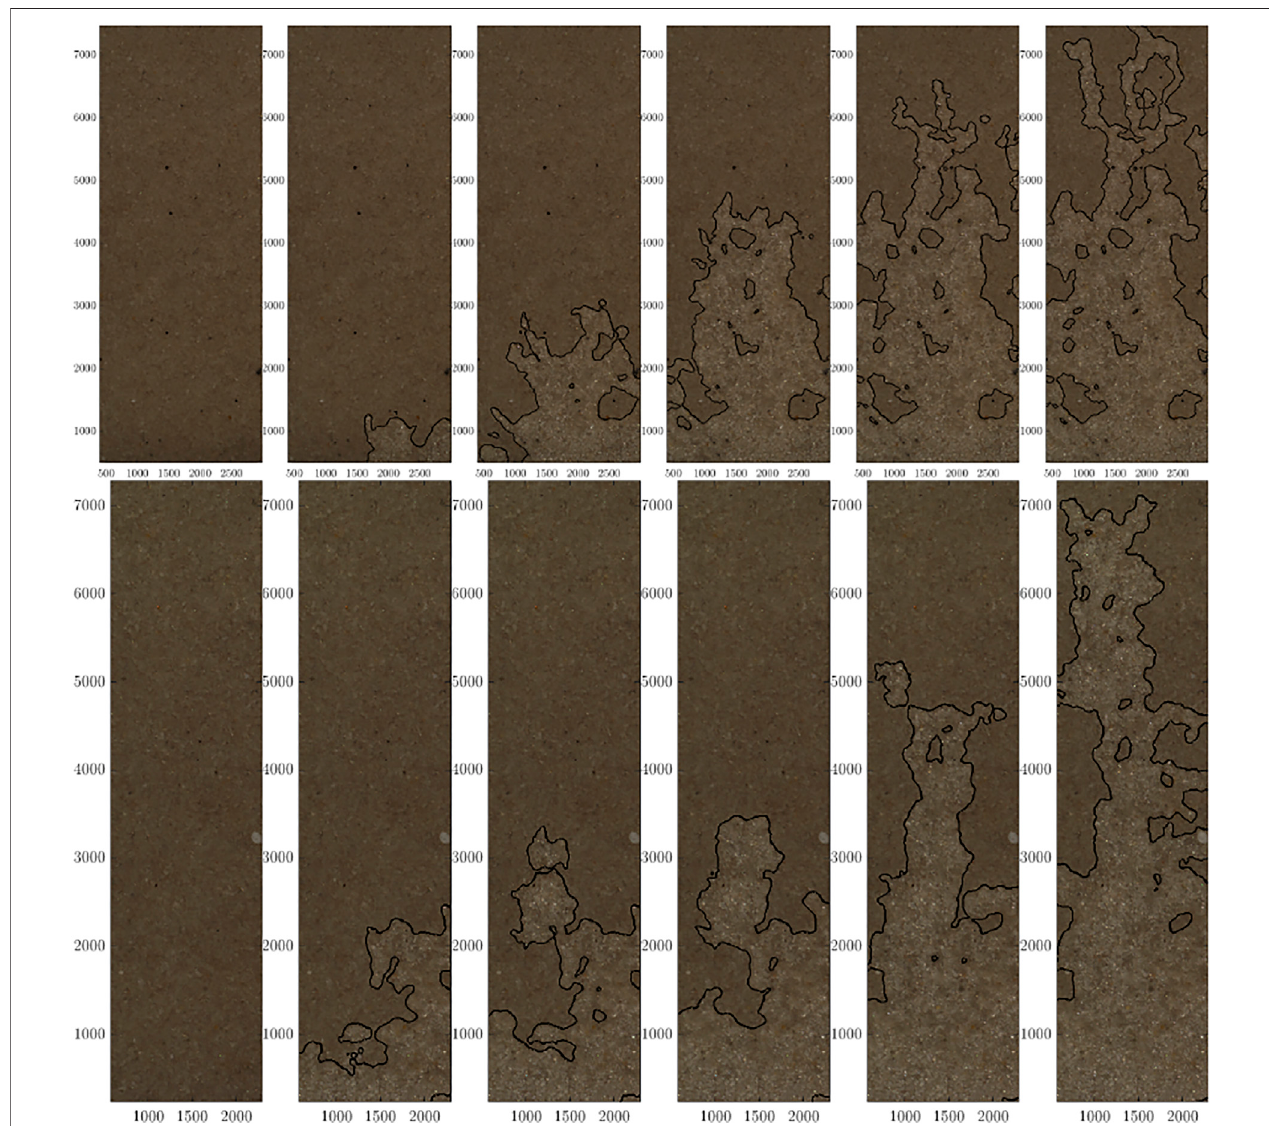
FIGURE 7 | Series of raw images acquired during the gas invasion for test (1) in the fi rst row and test (2) in the second row. The timestep between the deformed images is 1/3s for test (1) and 2/3s for test (2). The left column represents the reference states for both tests, and the remaining columns are for the deformed ones. The bright color indicates the gas, while the dark color indicates the water. The black lines represent the interfaces between saturated and unsaturated part of the sample.